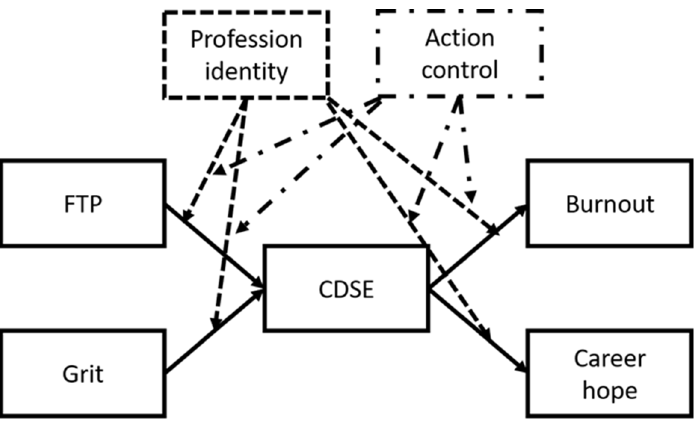
Figure 1. Study model.